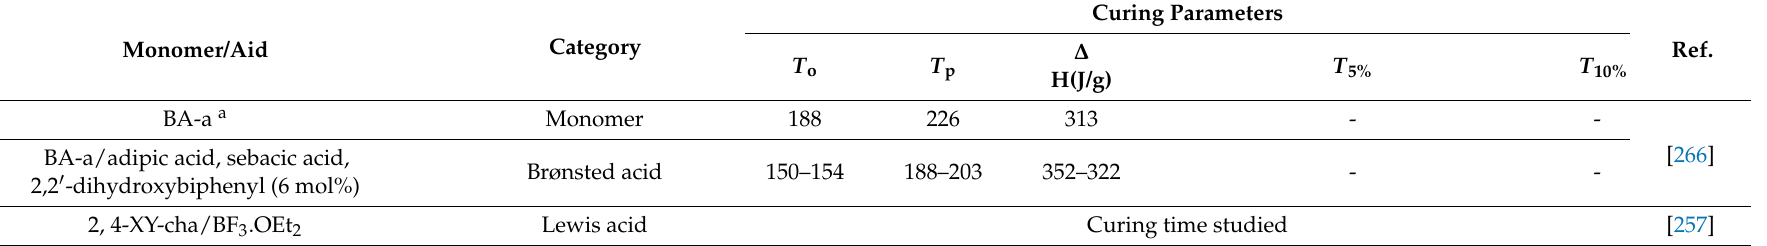
Table A1. DSC characteristics of representative benzoxazine monomers in presence of aid